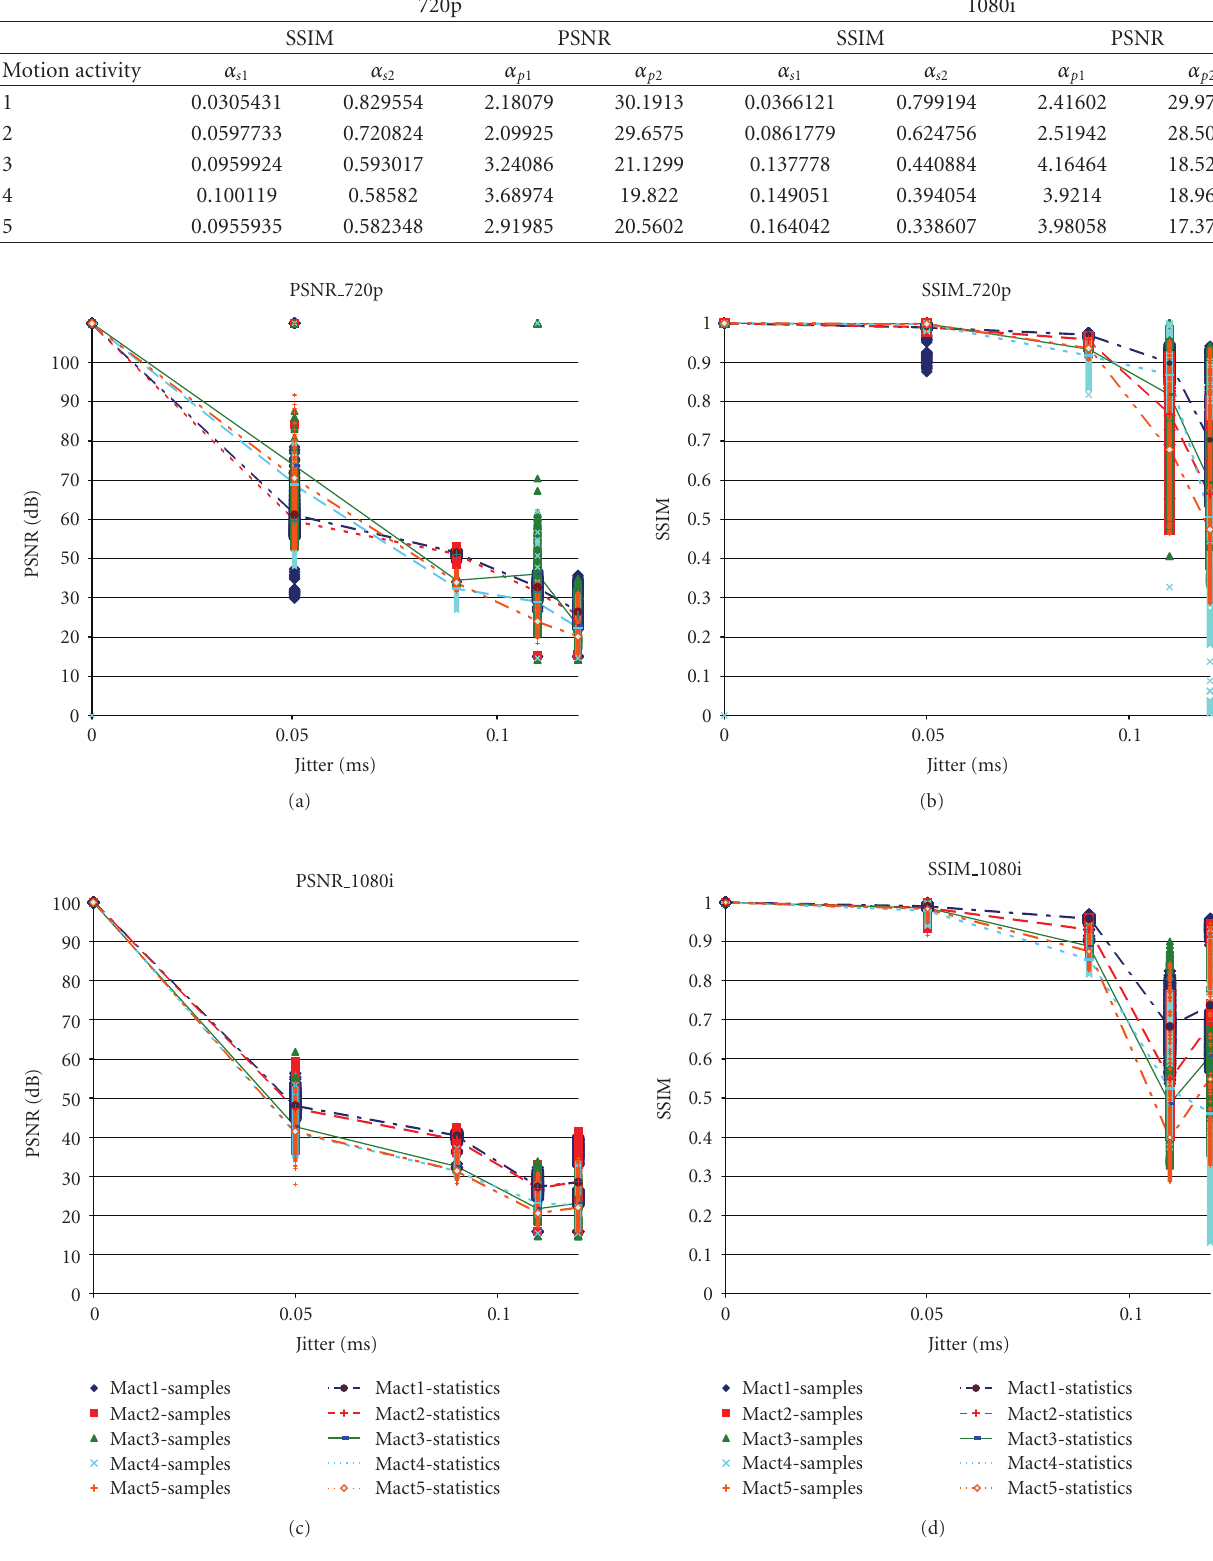
Figure 4: Graphs of the samples and mean curves of experimental data for the model Qm B2